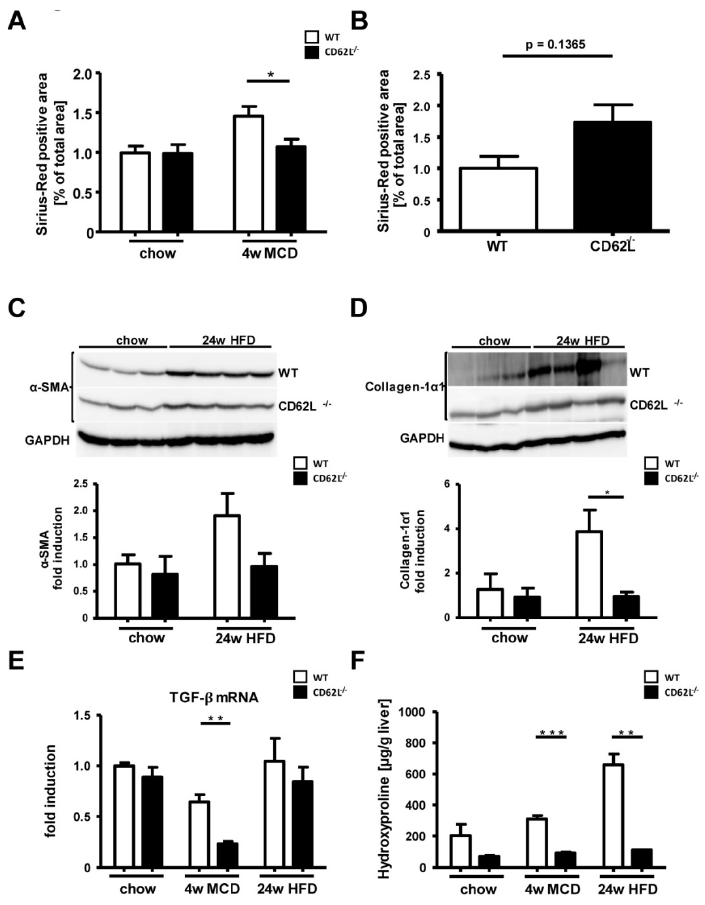
Figure 4. Weaker onset of fibrosis in CD62L − / − mice in two models of dietary induced steatohepatitis. ( A ) Quantitative analysis of Sirius Red staining of liver sections of chow and 4 w MCD fed WT and CD62L −/− mice was performed by calculating the Sirius Red positive area per view field of 10 view fields/liver by ImageJ (* p < 0.05). ( B ) Quantitative analysis of Sirius Red staining of liver sections of WT and CD62L −/− mice after 24 w HFD feeding was performed by calculating the Sirius Red positive area per slide. ( C ) α -SMA Western blot analysis from liver extracts of WT and CD62L −/− animals. ( D ) Collagen 1α1 Western blot analysis of liver extracts of chow and HFD fed WT and CD62L −/− animals (* p < 0.05). ( E ) Whole liver homogenates of chow, MCD (4 w) and HFD (24 w) fed WT and CD62L −/− mice were analysed for TGF- β mRNA expression via RT -qPCR. Values are expressed as fold induction over the mean values obtained for WT liver tissue (** p < 0.01). ( F ) Intrahepatic hydroxyproline content of WT and CD62L − / − animals after treatment with either chow diet or steatohepatitis-inducing diets (4 w MCD, 24 w HFD) (** p < 0.01, *** p < 0.001). All data are expressed as mean ± SEM ( n = 8). All experiments were repeated at least